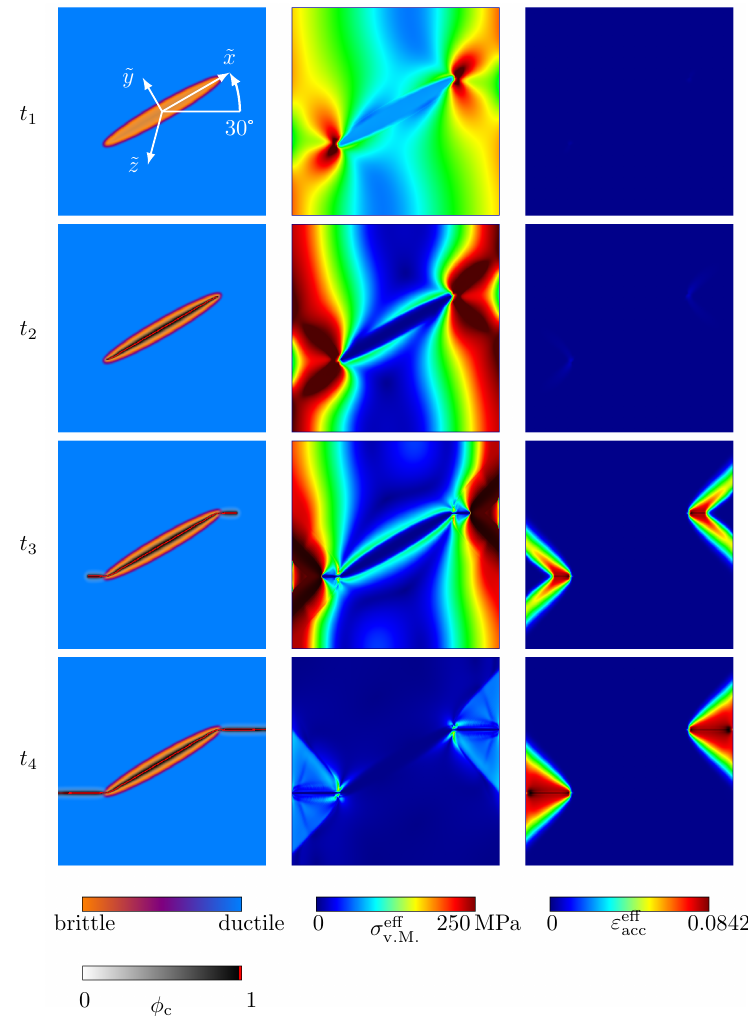
Figure 7. Contour plots of the evolution of the crack phase field φ c (first column) and the resulting von Mises stresses σ eff (second column), together with the effective accumulated plastic strain ε eff acc v.M. (third column) for the simulation setup with a single elliptic, transversely isotropic, brittle inclusion, embedded in a ductile matrix, for the set of standard parameters, Equation (32). The corresponding macroscopic uniaxial strain states are given in Figure